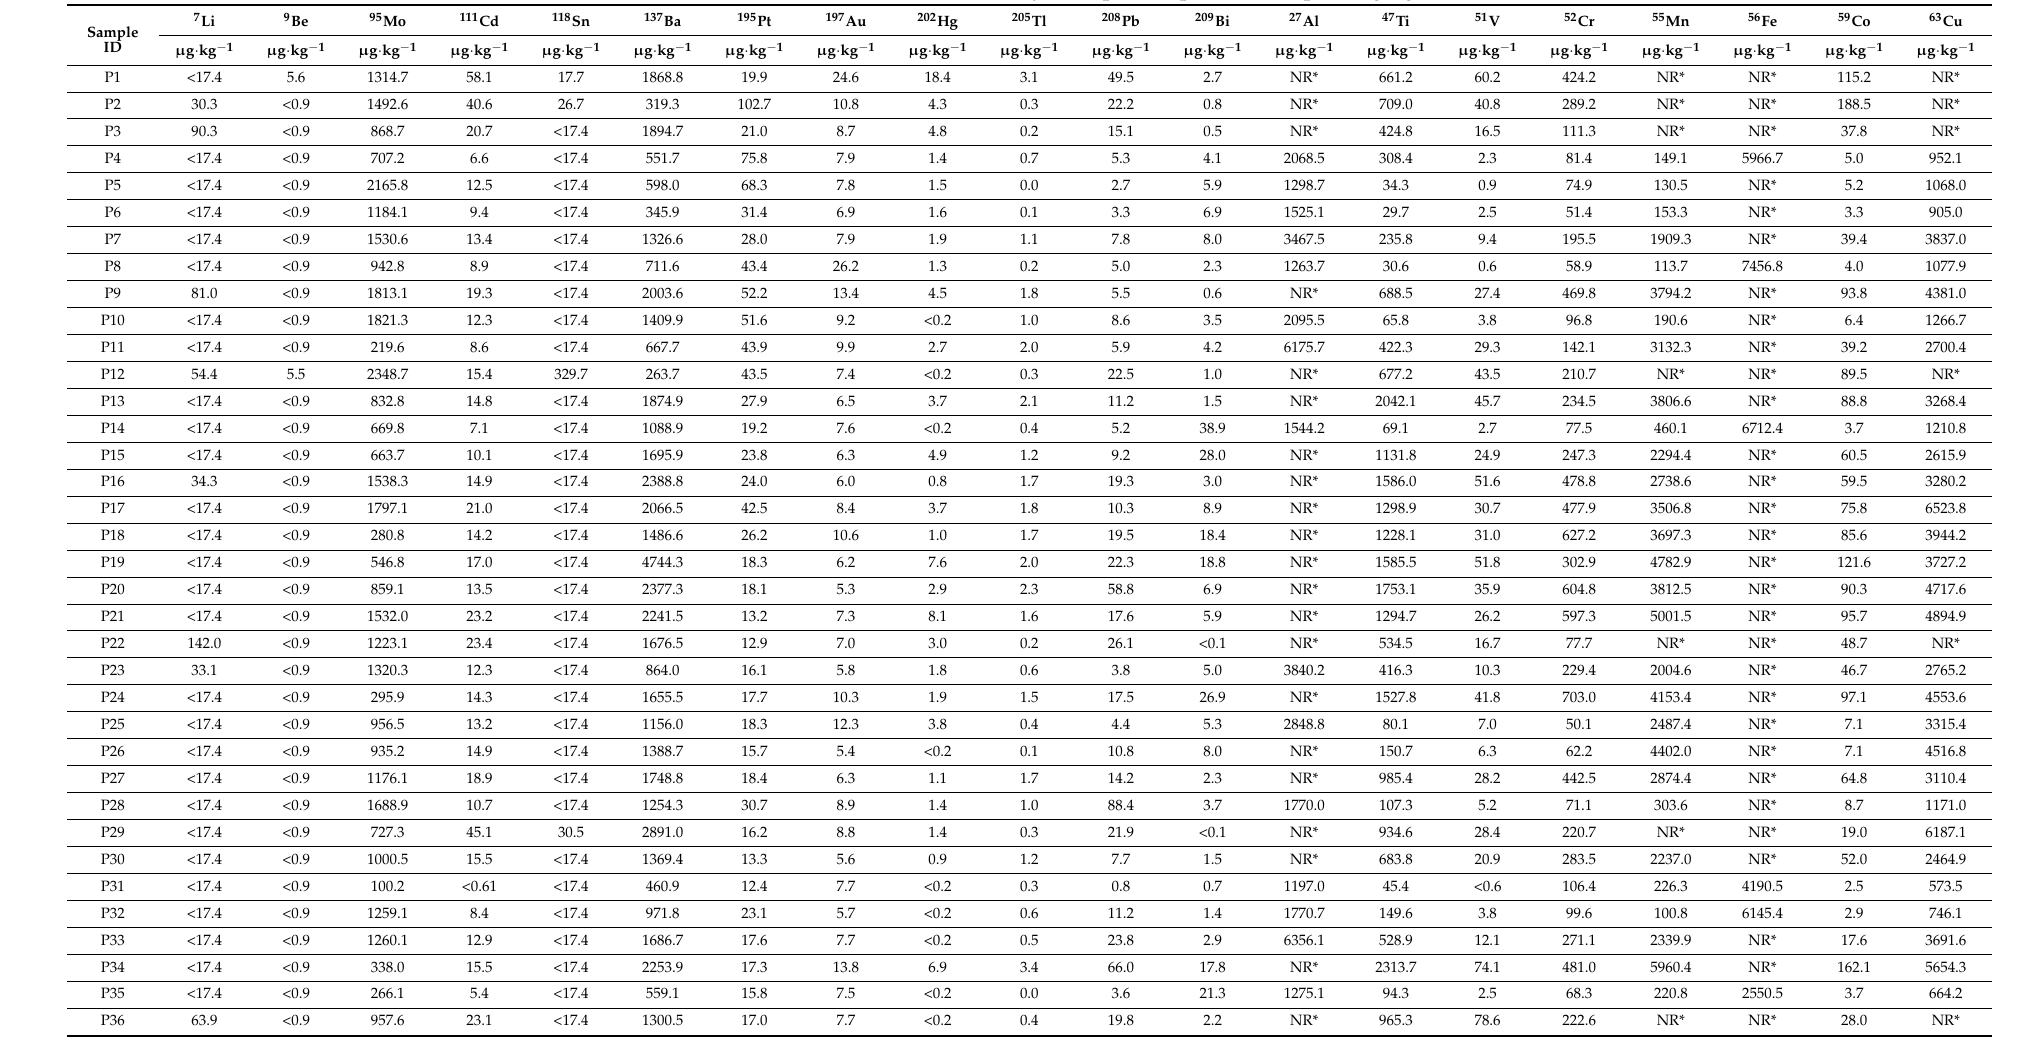
Table 6. Determined concentrations of analytes in protein powder samples ( µ g · kg − 1